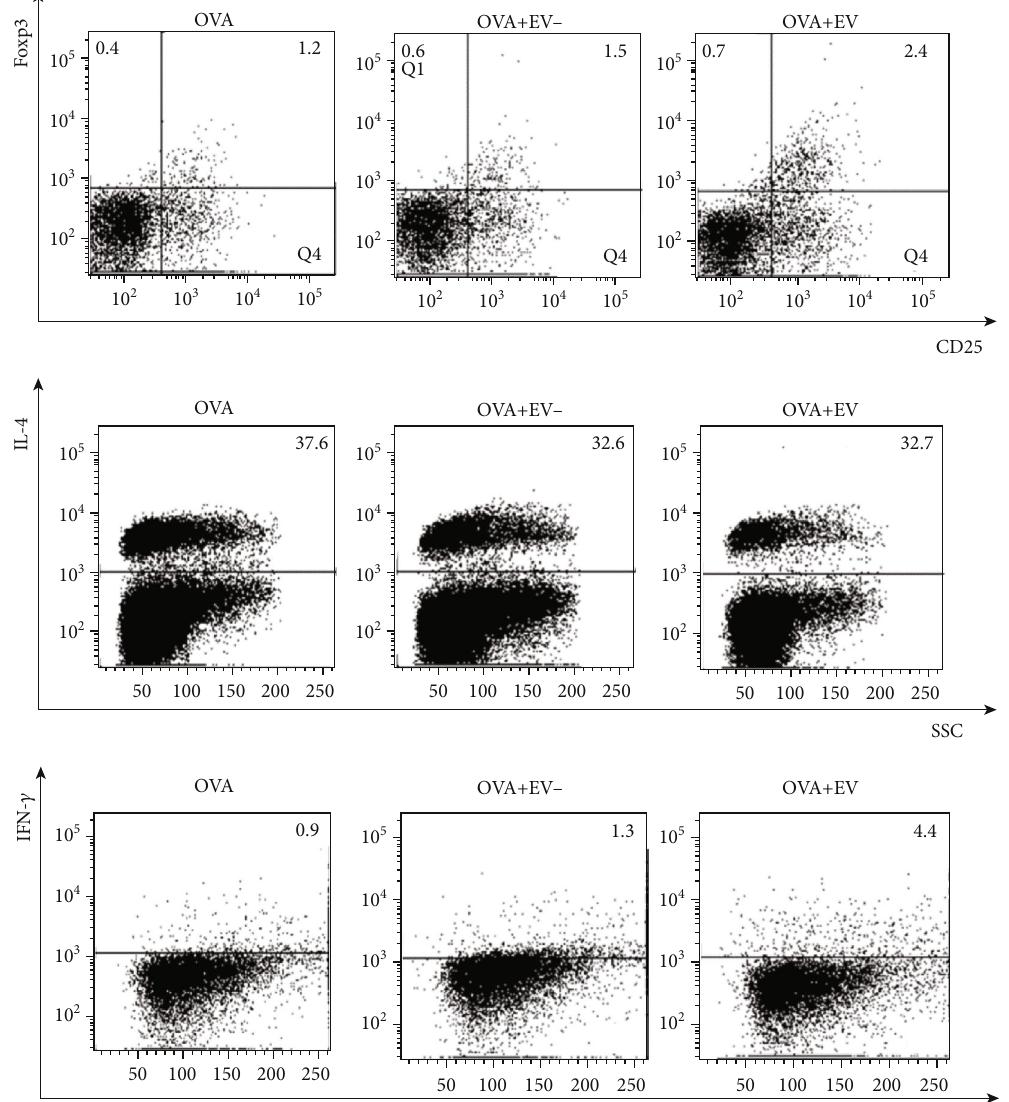
Figure 7: E ff ects of adipose stem cell- (ASC-) derived extracellular vesicles (EVs) on T cell populations in the lung draining lymph nodes. The populations of CD4 + CD25 + Foxp3 + T cells were markedly increased by administration of ASC-derived EVs in the OVA group. ASC-derived EV administration signi fi cantly reduced CD4 + IL-4 + T cells but promoted CD4 + IFN- γ + T